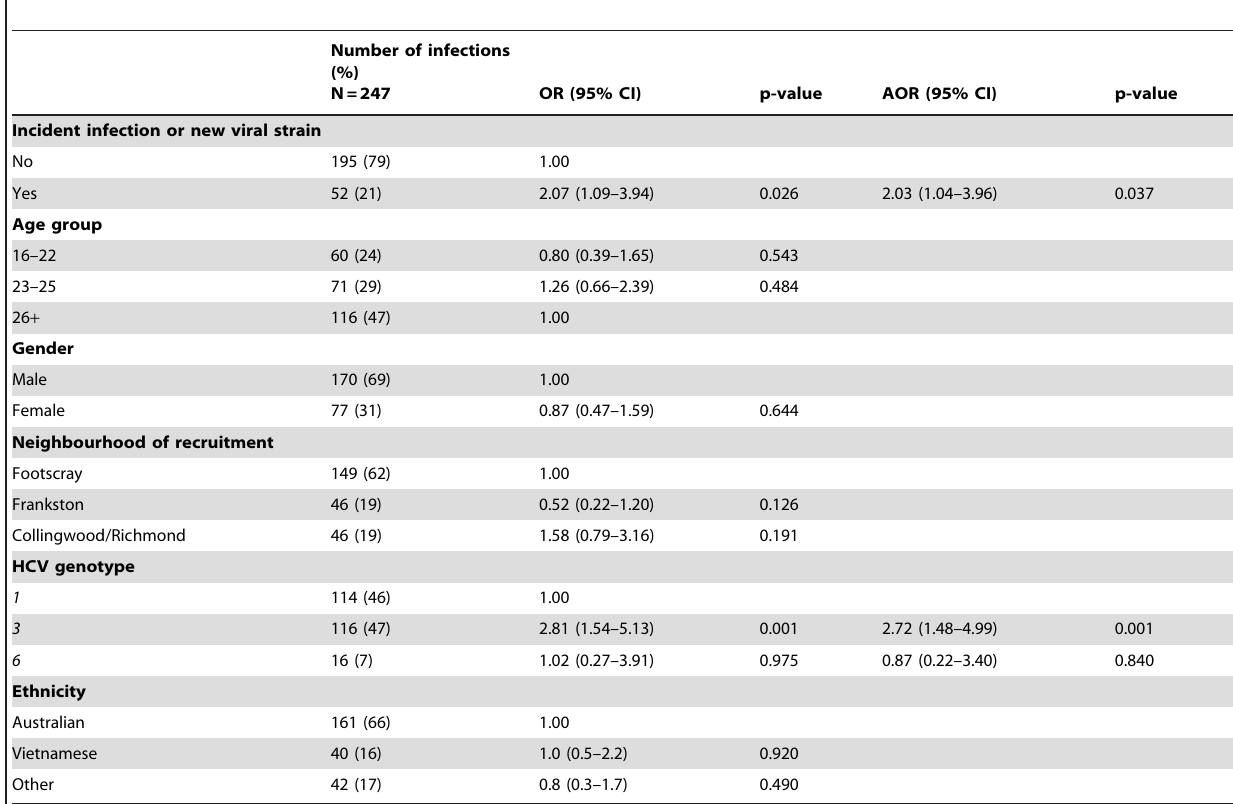
Table 2. Adjusted and unadjusted odds ratios of an infection being in a phylogenetic